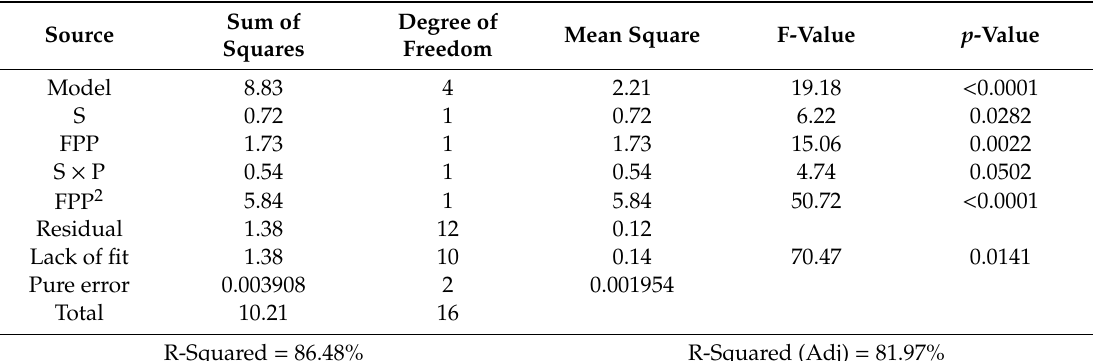
Table 8. Taper analysis ANOVA.